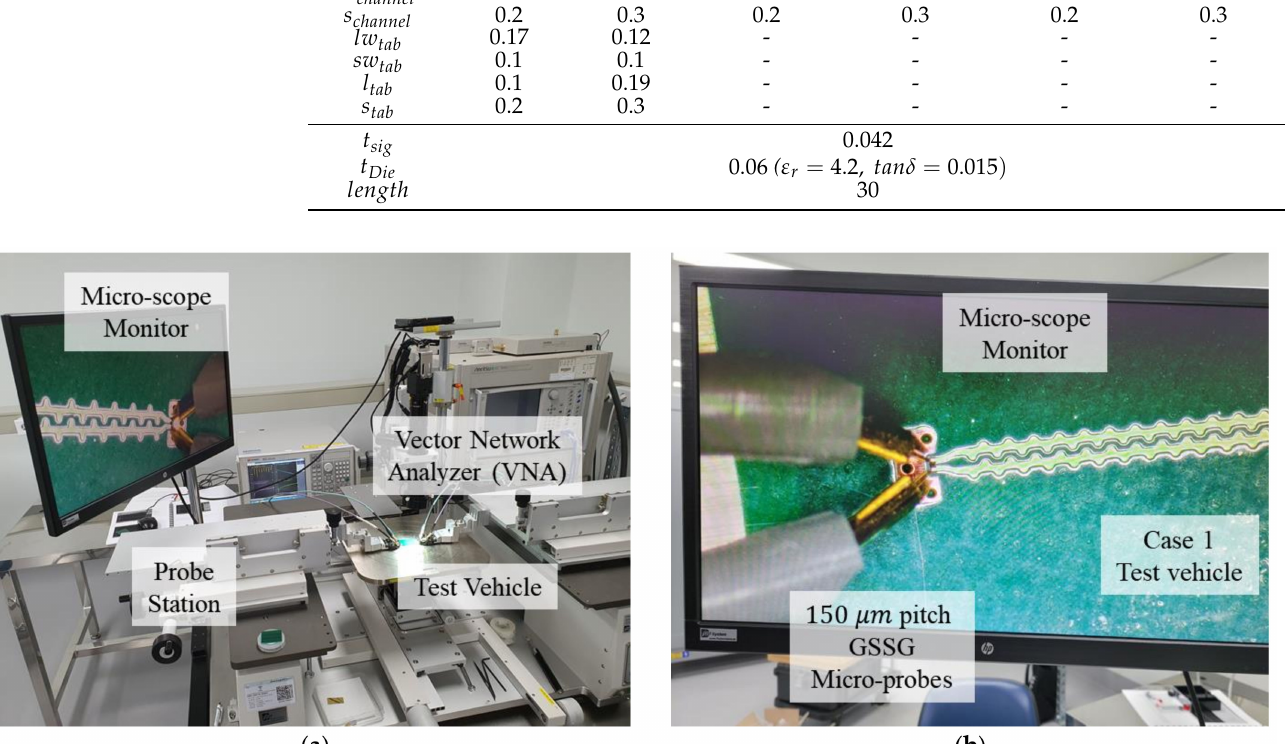
Figure 7. ( a ) Measurement environment for experimental verification of the tabbed routing model. A VNA is used for insertion loss and FEXT measurement in the frequency domain. ( b ) Micro-scope image of the GSSG probe and test vehicle (case